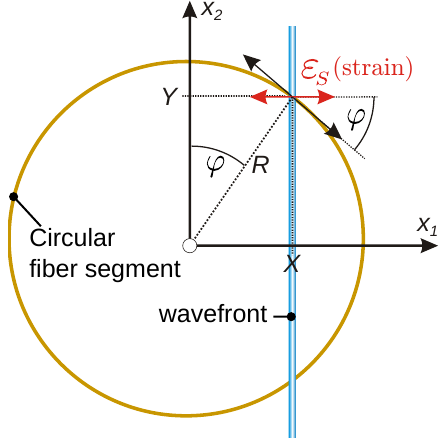
Figure 5. Derivation of the strain conversion by circular fibers for plane compressional